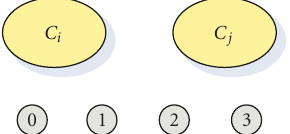
Figure 1: The display configuration used in our experiments for judging image similarity between images belonging to the same cat- egory, using perceptual